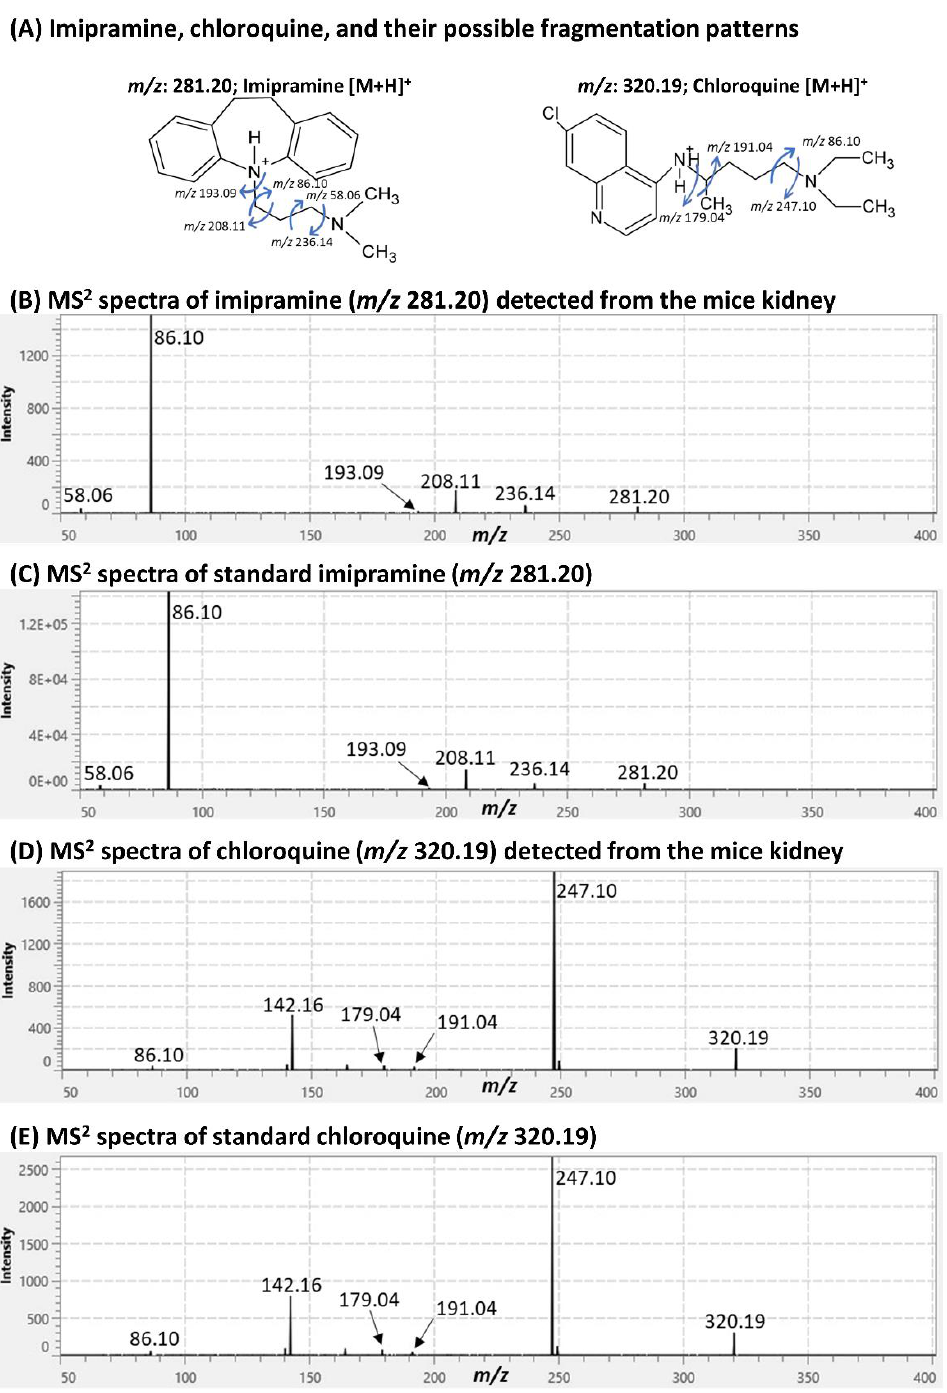
Figure 2. Tandem MS (MS 2 ) spectra of imipramine and chloroquine acquired by iMScope QT from treated mice kidneys and standard drugs. ( A ) Possible fragmentation patterns of imipramine and chloroquine. ( B , C ) MS 2 spectra of imipramine acquired from treated mice kidneys and standard imipramine. ( D , E ) MS 2 spectra of chloroquine acquired from treated mice kidneys and standard chloroquine. α -Cyano-4-hydroxycinnamic acid (CHCA) was used as the matrix.